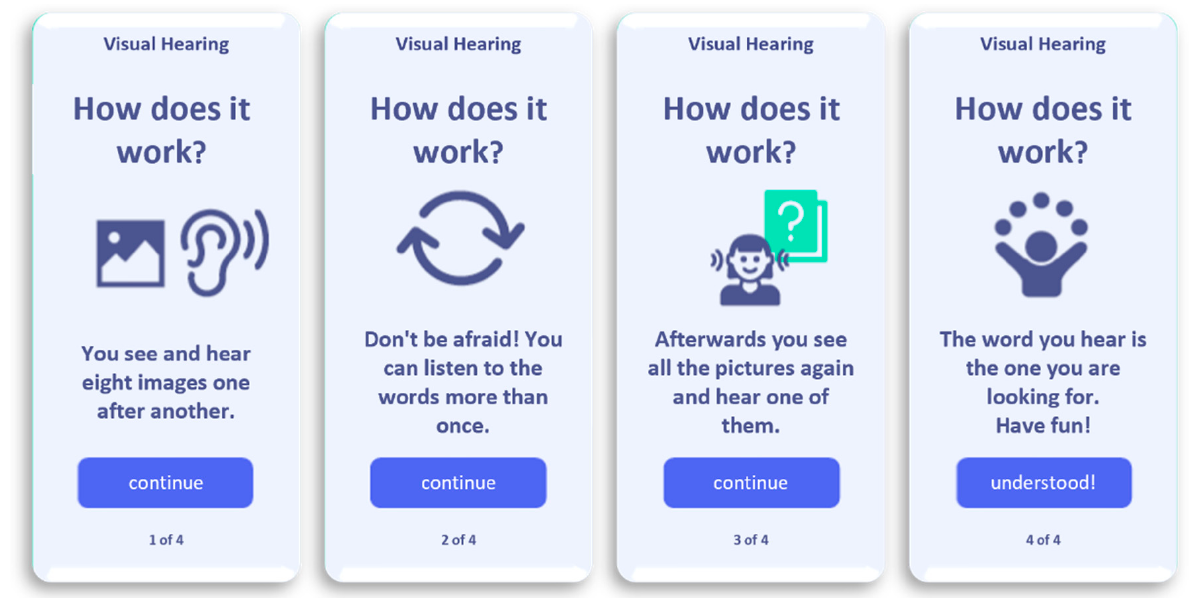
Figure 2. Exemplary illustration of the explanation for an easy word exercise.